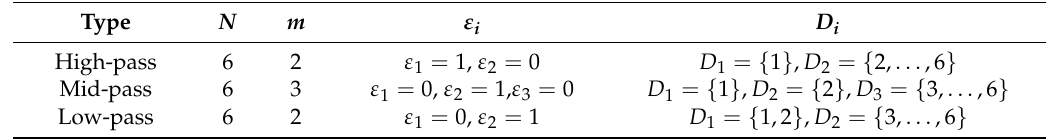
Table 1. Parameter list for three types of dip filters.